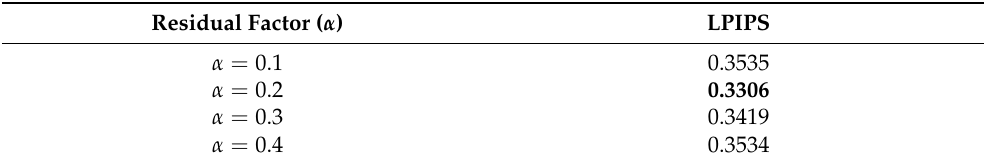
Table A2. Mean value of LPIPS for models with different residual scaling factors, where α represents the residual scaling factor. The best performance in